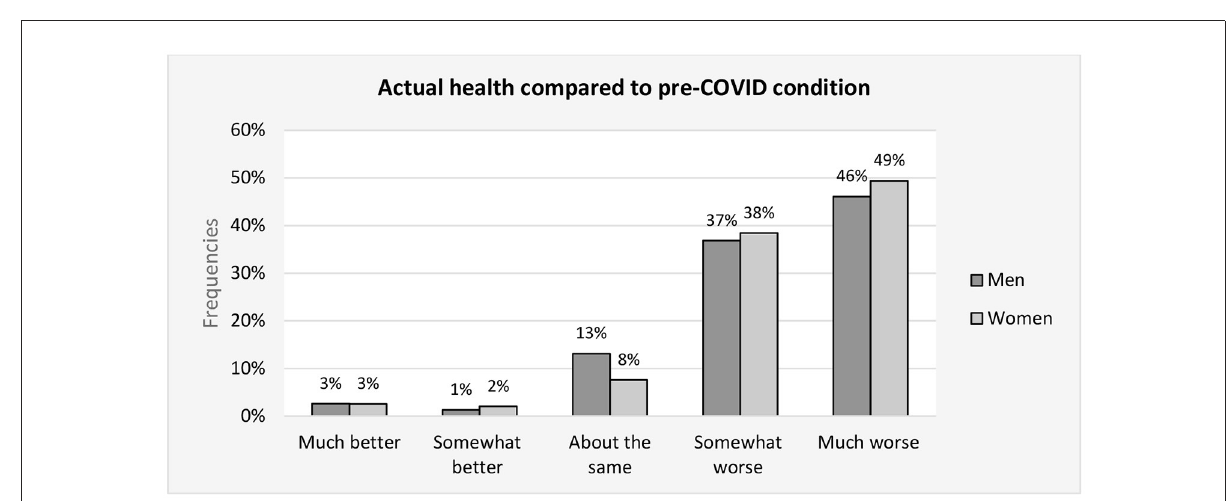
FIGURE2 Actual health compared to pre-COVID condition - frequencies of patient